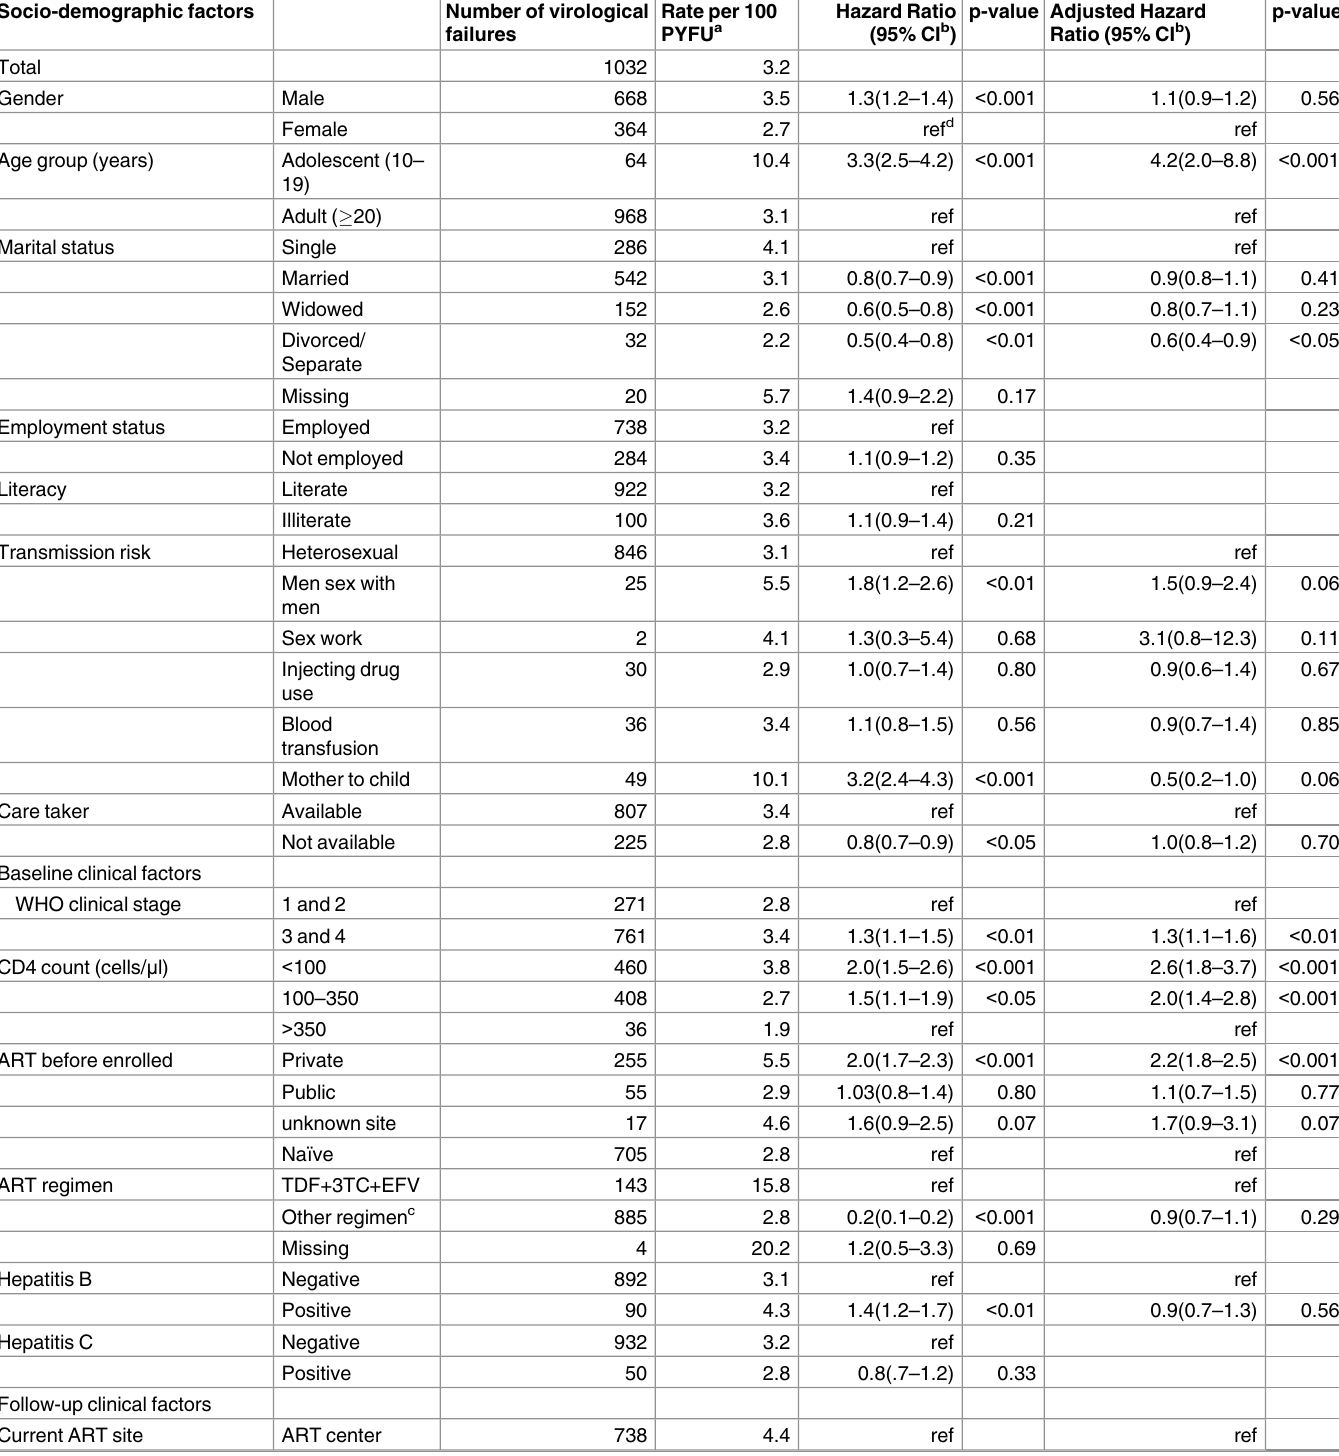
Table 2. Rates and predictors of virological failure in patients initiated on first-line ART in the Integrated HIV and Care Program in Myanmar between 2005 and 2015. Socio-demographic